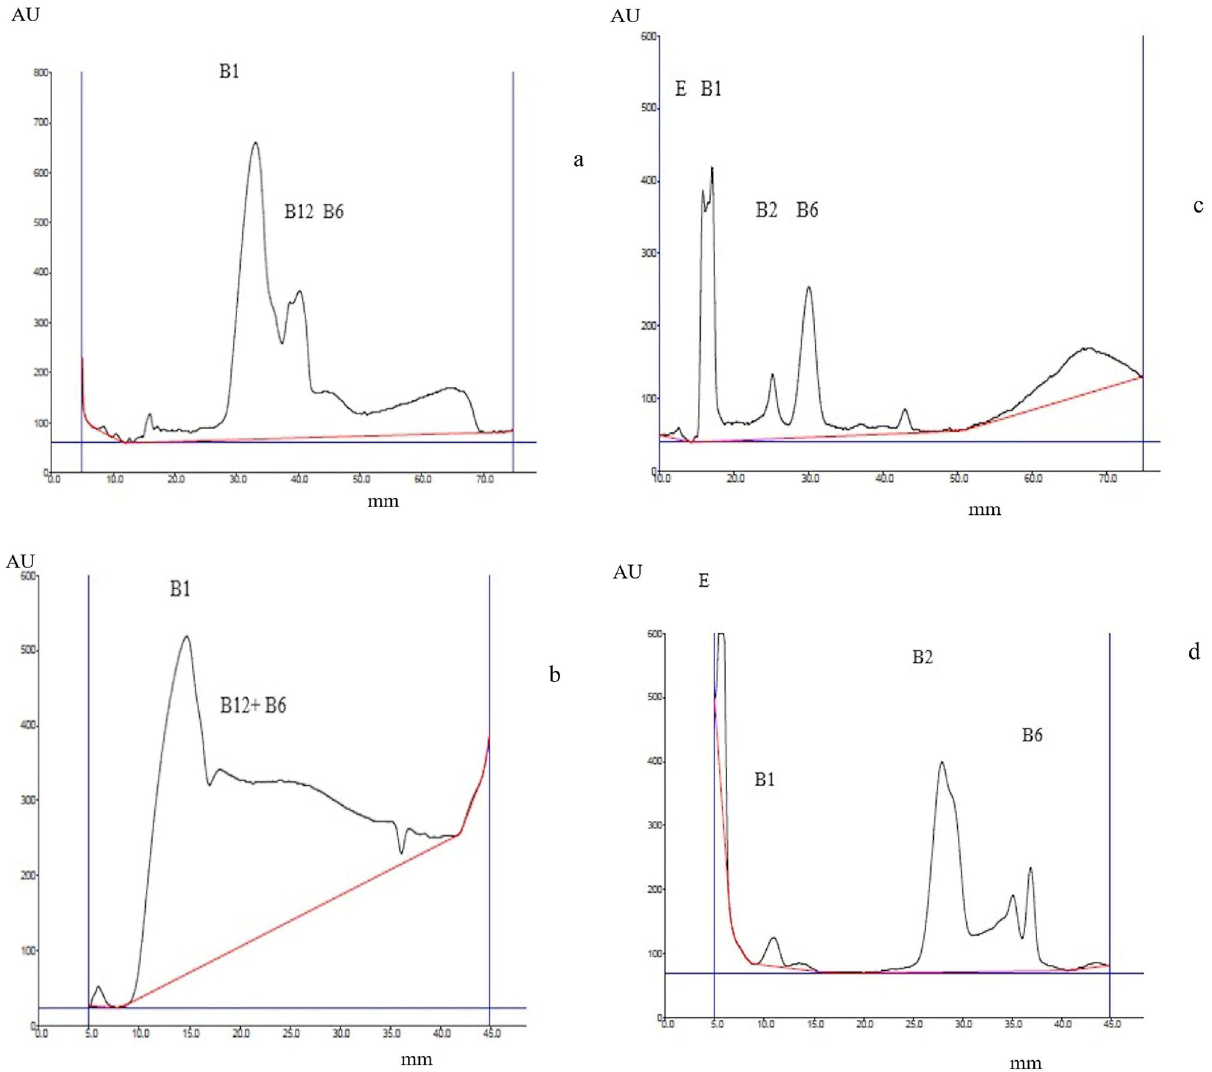
Figure 5. Separation of commercially available vitamin mixtures (Neurovit ( a , b ) and Tiolip ( c , d ) by way of applying PPEC and TLC techniques. The mobile phase consisted of 50% acetonitrile, a buffer of pH 6.99 ((acetic acid, phosphoric acid, and boric acid (2.74 mM each) and sodium hydroxide (8.60 mM)), as well as 18.75 mM SDS. For Neurovit and the PPEC technique ( a ), the experiment was carried out for 4 min using a polarisation voltage of 1200 V. For Tiolip ( c ), the PPEC technique was applied for 6 min, and the voltage was 1200 V. For both drugs, the TLC (Neurovit (Fig. 5b), Tiolip ( d ) experiments lasted about 11 min. Detection was at 254 nm.